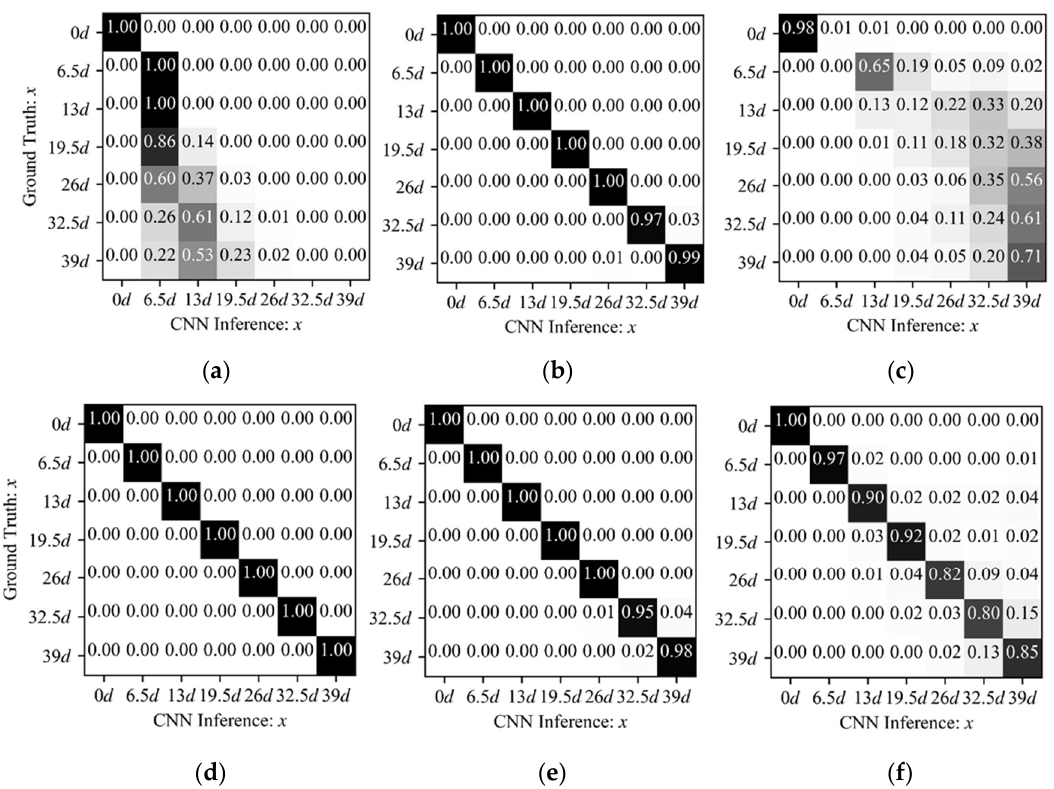
Figure 6. Accuracy of determination for image angle 0°: ( a ) Learner D tested by “large size” images; ( b ) same as ( a ), but tested by middle size; ( c ) same as ( a ), but tested by small size; ( d ) Learner E tested by “large size” images; ( e ) same as ( d ), but tested by middle size; ( f ) same as ( d ), but tested by small size.